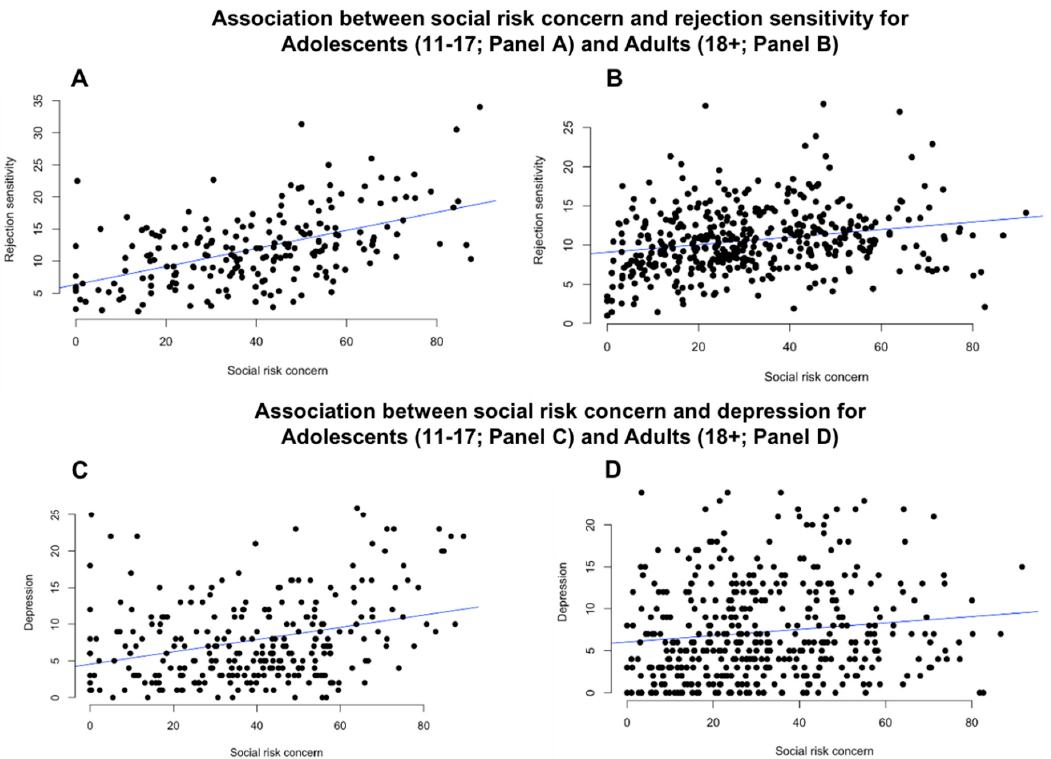
Figure 1. Relationship between concern for social risk and rejection sensitivity for adolescents ( r (205) = 0.52, p < 0.001; panel ( A ) and adults ( r (413) = 0.22, p < 0.001; panel ( B ). Relationship between risk concern and depression for adolescents ( r (279) = 0.31, p < 0.001; panel ( C ) and adults ( r (413) = 0.13, p = 0.009; panel ( D ). The strength of the correlations between concern for social risk and rejection sensitivity and depression was stronger for adolescents than for adults (rejection sensitivity: Z = 4.12, p < 0.001; depression: Z = 2.45, p = 0.007).